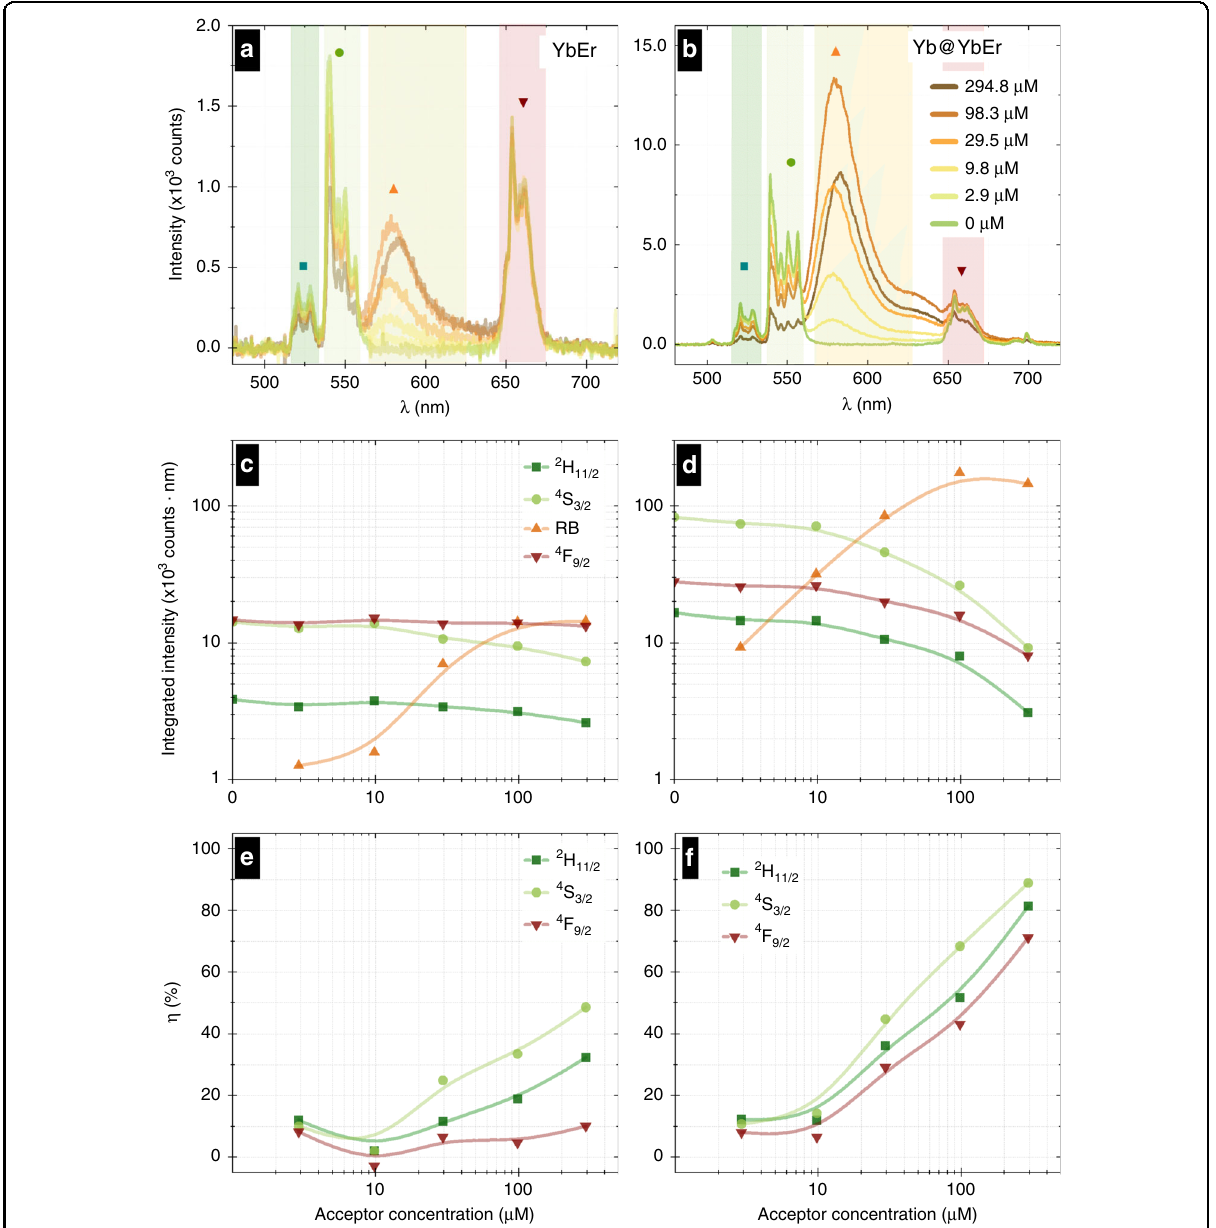
Fig. 2 Steady-state spectral properties of YbEr and Yb@YbEr samples undergoing UC-LRET to Rose Bengal acceptor. Steady-state upconversion spectra (980 nm excitation) of a core only and b core-shell UCNPs with different concentrations of Rose Bengal attached to their surface. Rose Bengal concentration-dependent integrated steady-state emission intensities from 2 H 11/2 ( ), 4 S 3/2 ( ), and 4 F 9/2 ( ) levels of Er 3 + ions as well as sensitized emission intensity from RB ( ) for c YbEr and d Yb@YbEr, respectively. RB concentration-dependent UC-LRET ef fi ciency for e YbEr and f Yb@YbEr, respectively, were calculated from intensity changes of different donor emission bands in response to acceptor presence. Integrals are based on spectral ranges indicated in a ,